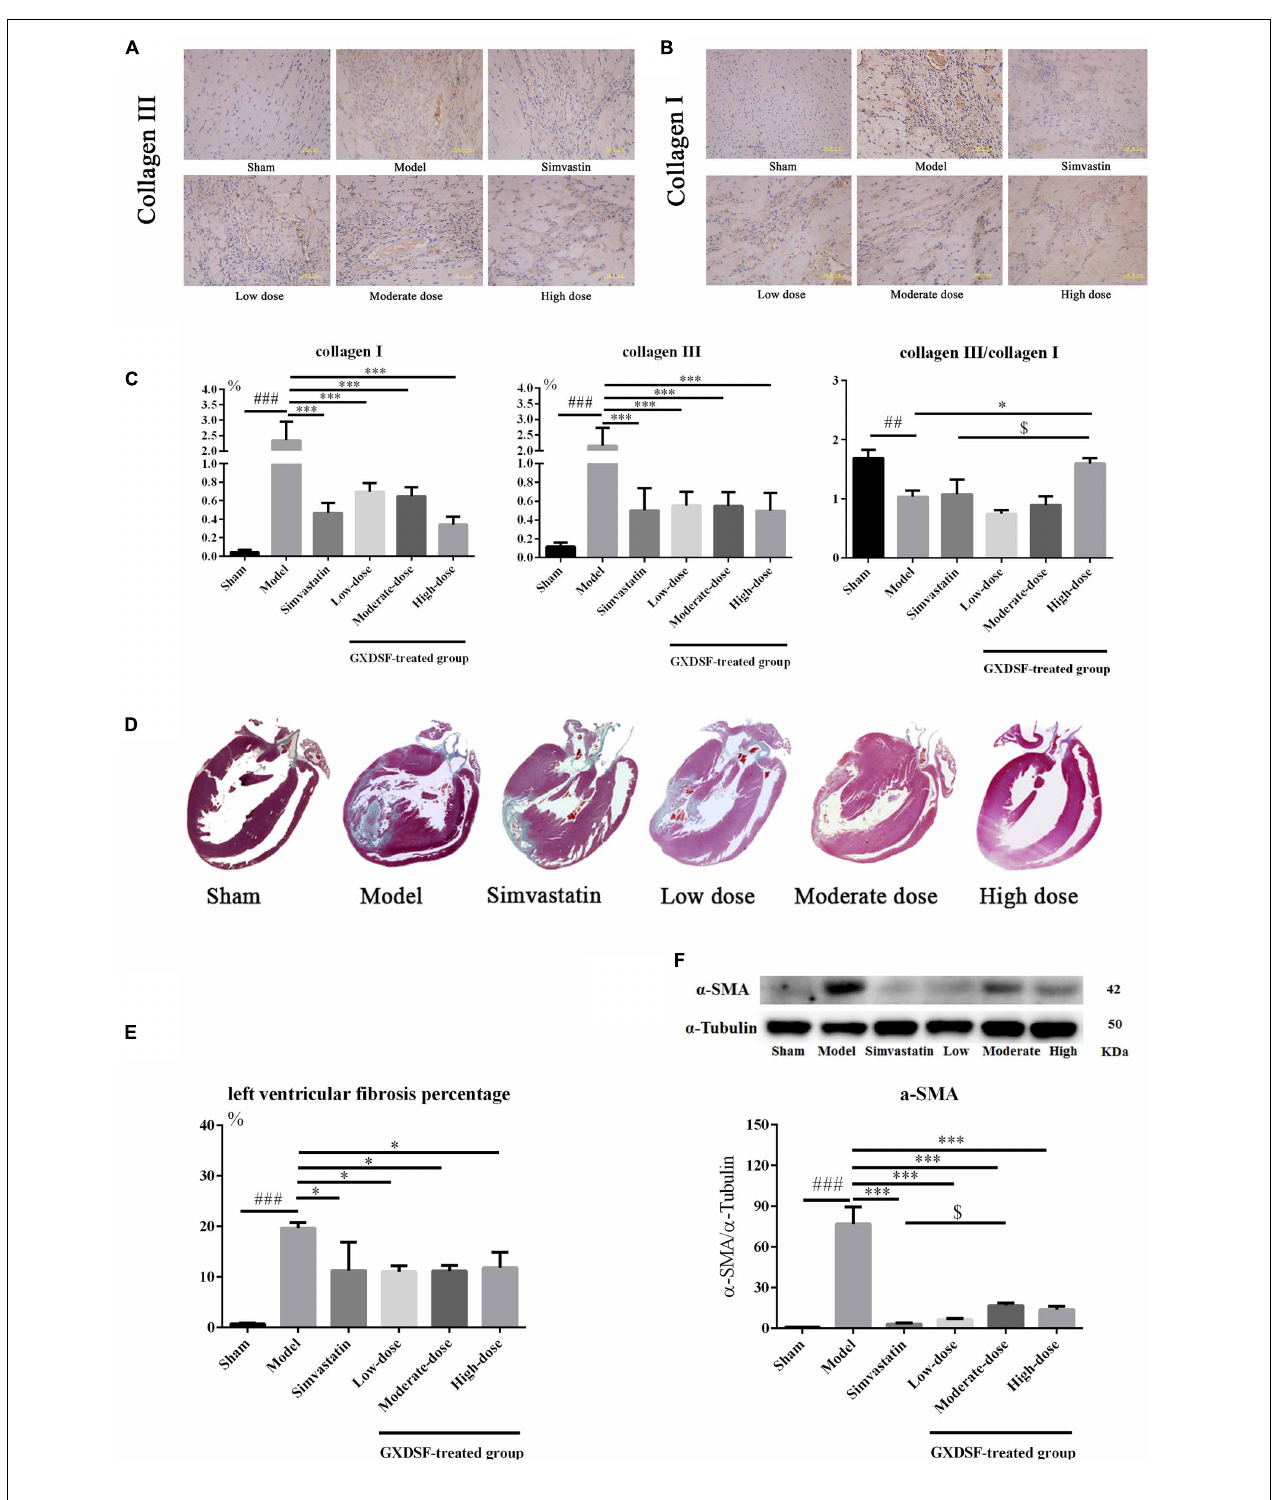
FIGURE 6 | Myocardial fibrosis in MIRI-LVR rats treated with different doses of GXDSF. The immunohistological localization of collagen III (A) and collagen I (B) is shown. Bars represent 50 µ m. The relative expression of collagen I and III and the relative ratio of collagen III/I (C) are shown in bar graphs. Masson’s trichrome staining (D) and the percentage of left ventricular fibrosis area (E) are provided. A gel image with an internal reference ( α –tubulin) and the relative expression of α –SMA ( F ; column graph) are shown. Compared with the sham group: ## P < 0.01, ### P < 0.001. Compared with the MIRI-LVR model group: ∗ P < 0.05, ∗∗∗ P < 0.001. Compared with the simvastatin group: $ P < 0.05. The data are presented as the mean ± SD ( n = 4 in each group).